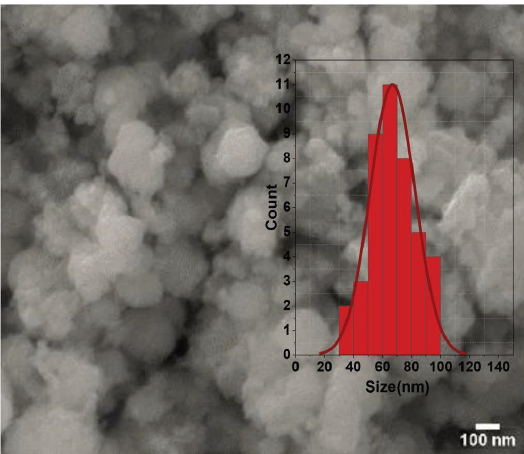
Figure 4: FESEM image (inset) nanoparticles